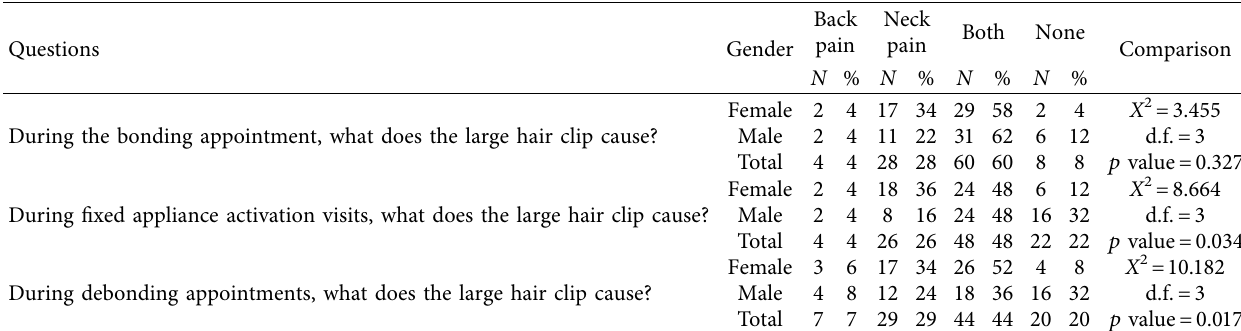
Does the large hair clip disturb you while taking dental impressions?